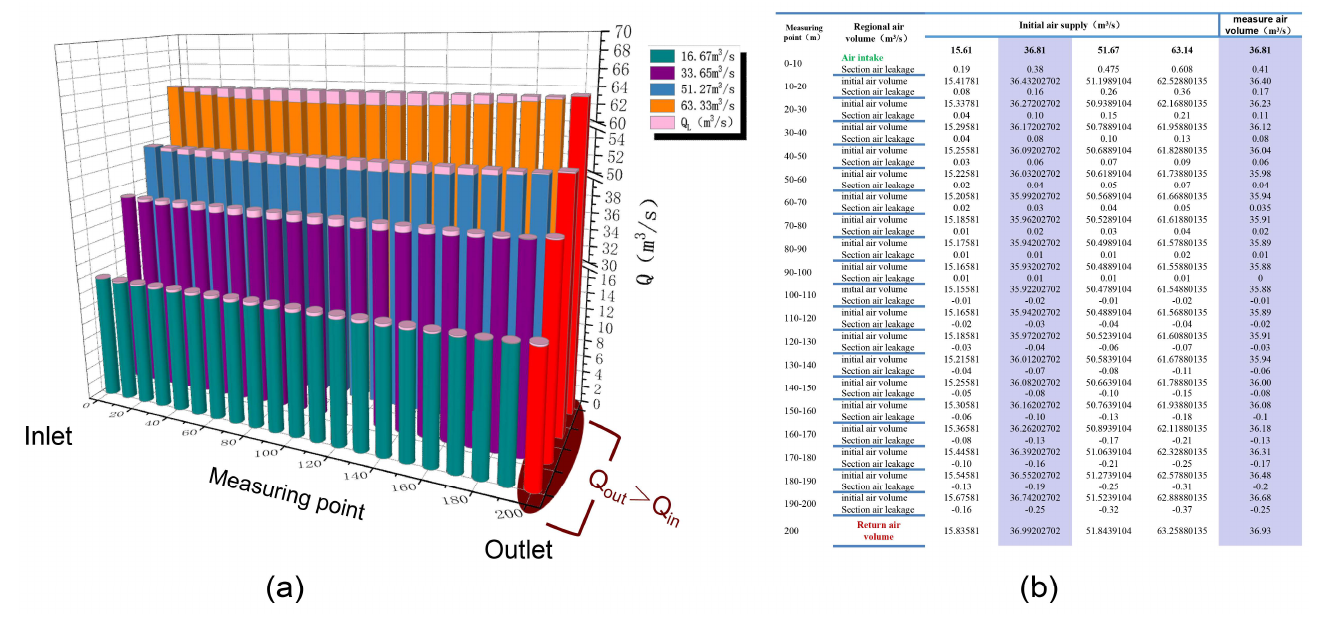
Figure 7. Variation of air volume in each working face area under different air volumes. ( a ) The inclination air volume of the working face; ( b ) the leakage air volume of the working face.